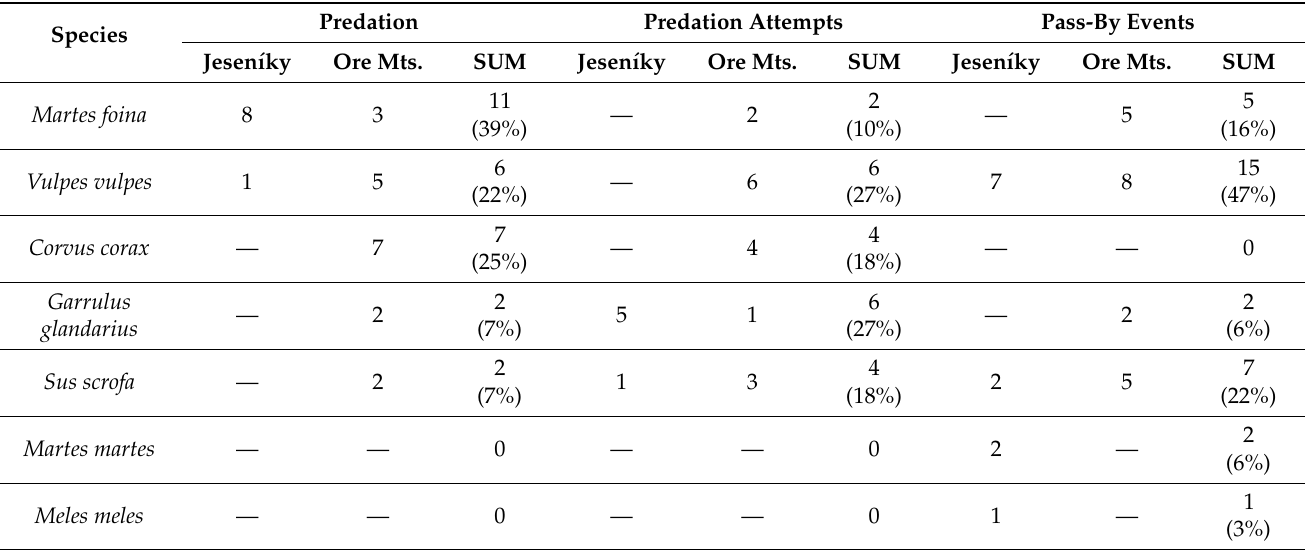
Martes martes Meles